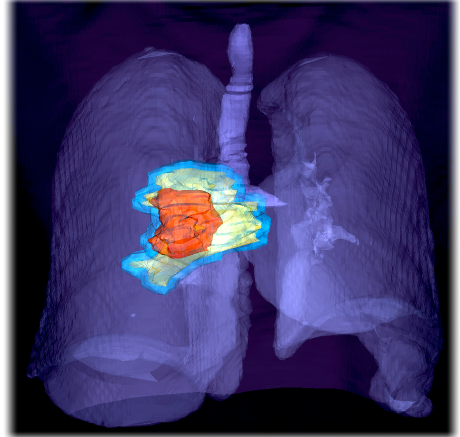
Figure 1. Example of a CT image of a patient suffering from Non-Small Cell Lung Cancer (NSCLC), where we highlight the segmentations corresponding to Gross Tumour Volume (GTV) (red), Clinical Target Volume (CTV) (yellow), and Planning Target Volume (PTV)